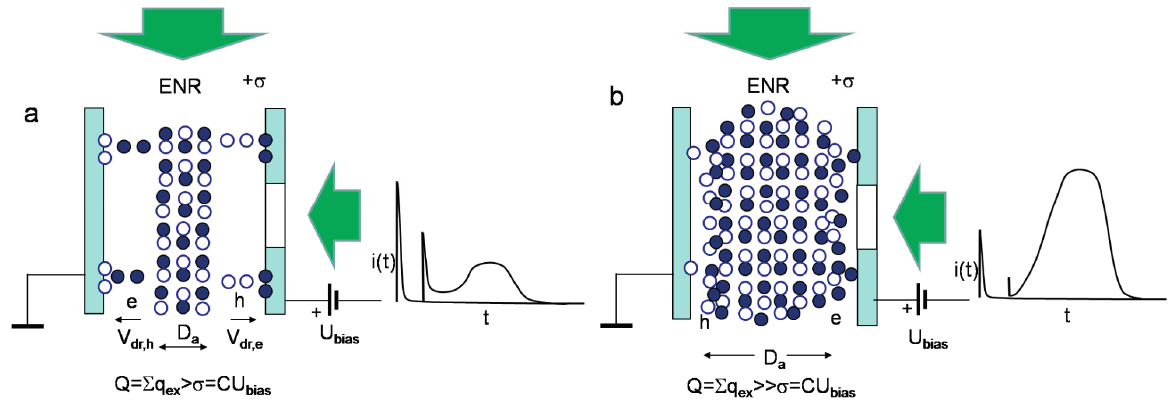
Figure 6. Sketches of diffusion current formation under large amount of the light injected carrier pairs, when a partial or complete screening of the external field by injected carriers appears. ( a ) Formation of the partial dynamic depletion layers, separated by ENR-electrically neutral region (filled with non-separated excess carriers) which supplies diffusing carriers from ENR (for drift within near-electrode regions), during formation of a current pulse under the light injected bulk charge. Energy diagram is here skipped. On the right, a diagram of capacitor charging, of drift current and of diffusion component pulses is sketched; ( b ) Sketch of the diffusion prevailing current pulse under bulk injection of the large amount of the excess carrier pairs which charge is capable to completely screen the external field. Notifications and assumptions are the same as for Figure